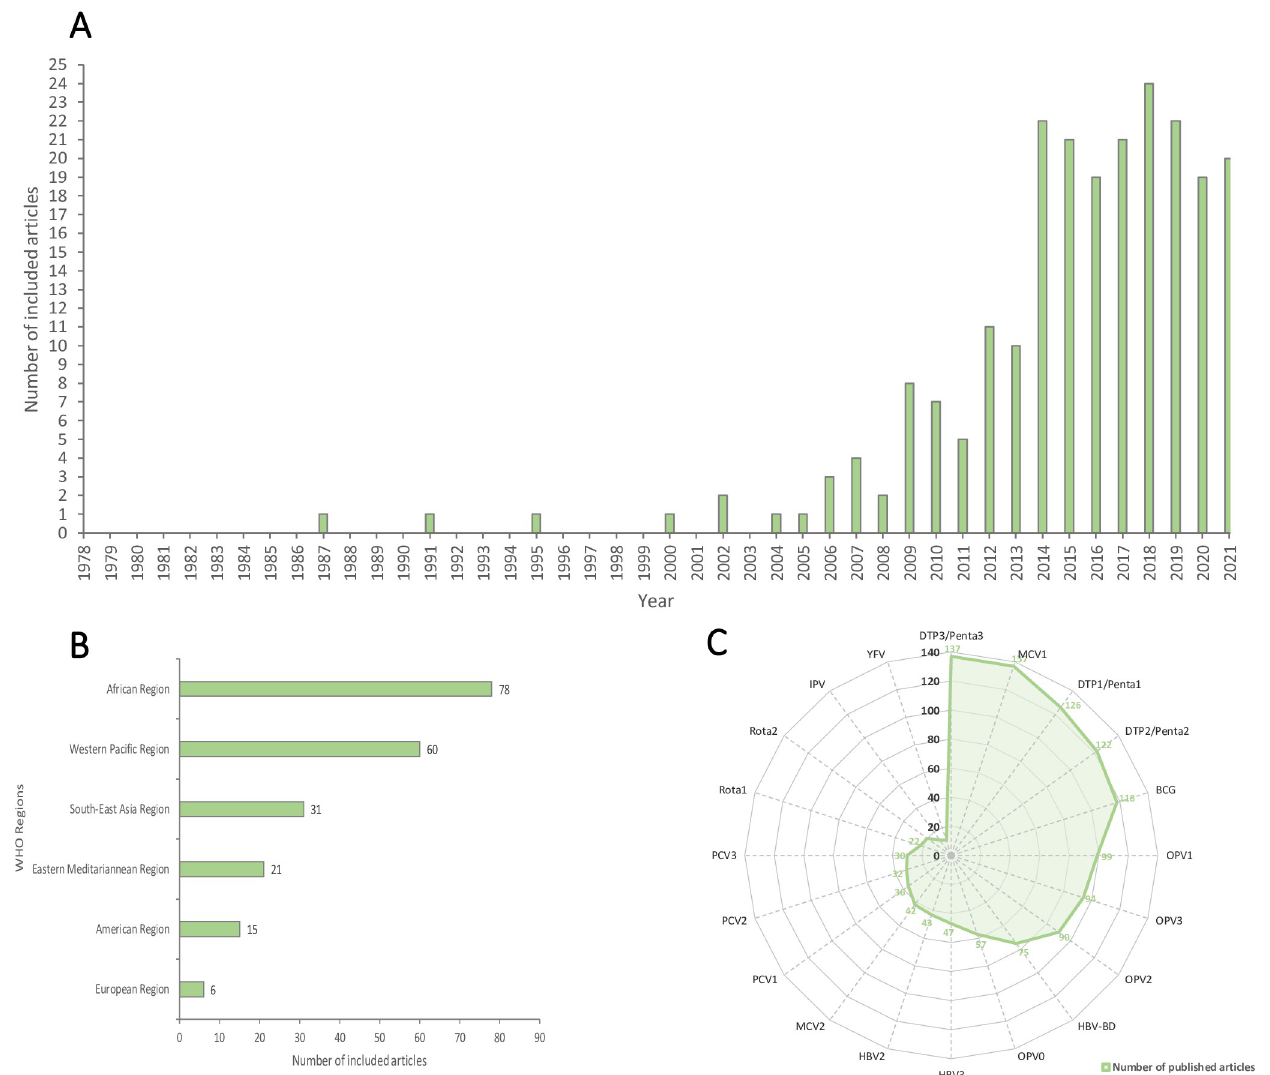
Fig 2. (a) How the literature on the timeliness of routine childhood vaccination has evolved, 1978–2021 Number of studies published per year (b) number of studies published per WHO region (c) antigens studied in the published